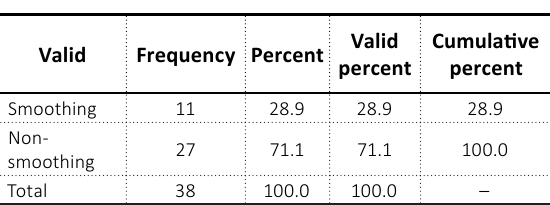
Table 4 classifies companies by sector: banks and